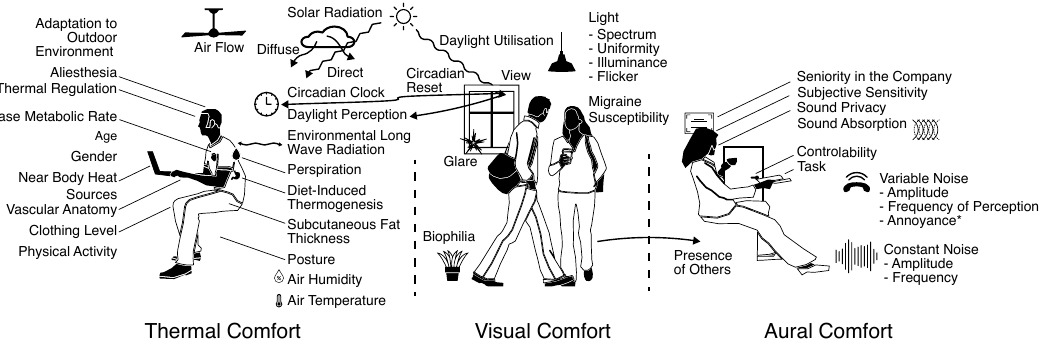
Figure 1. Graphical review of physiological, psychological and environmental factors influencing human comfort. Thermal—clockwise from top left: adaptation to outdoor environment [4], air flow [14],